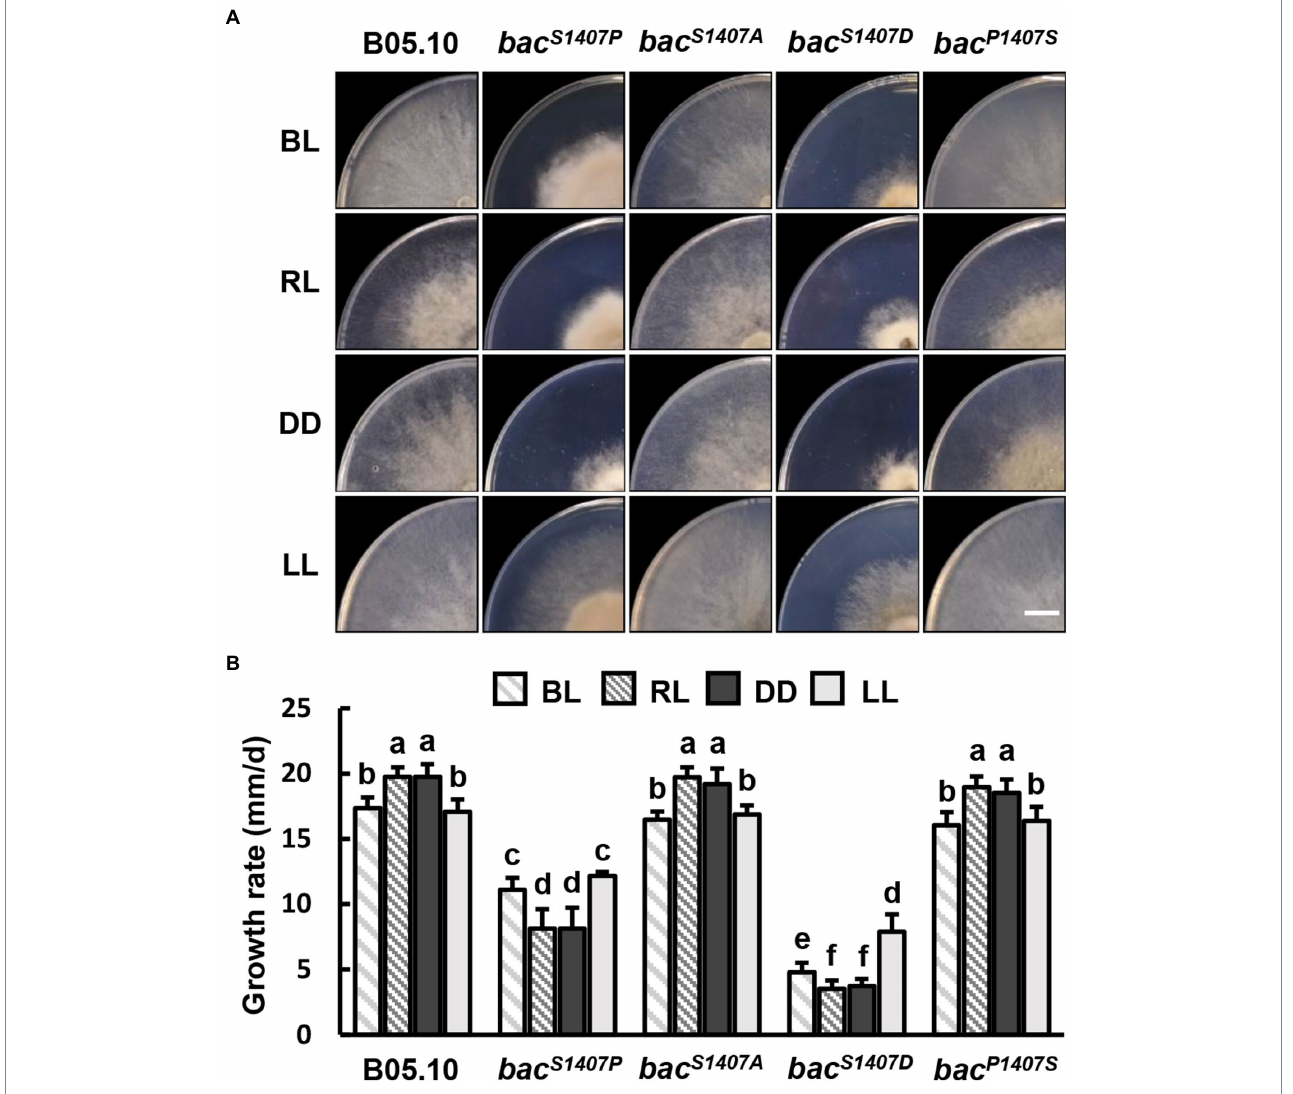
FIGURE 5 (A) Colony appearance of different strains under blue light (BL), red light (RL), continuous dark (DD), and continuous light (LL) conditions. Wild-type (B05.10) and mutant strains ( bac S1407P , bac S1407A , bac S1407D , and bac P1407S ) were incubated onto the solid CM medium for 3 days under BL, RL, DD, and LL conditions. The white bar represents 10 mm. (B) The colony growth rate of test strains under the same conditions as those depicted in (A) . Different letters indicate significant differences at p < 0.05. The bars present mean values ± SDs ( n =